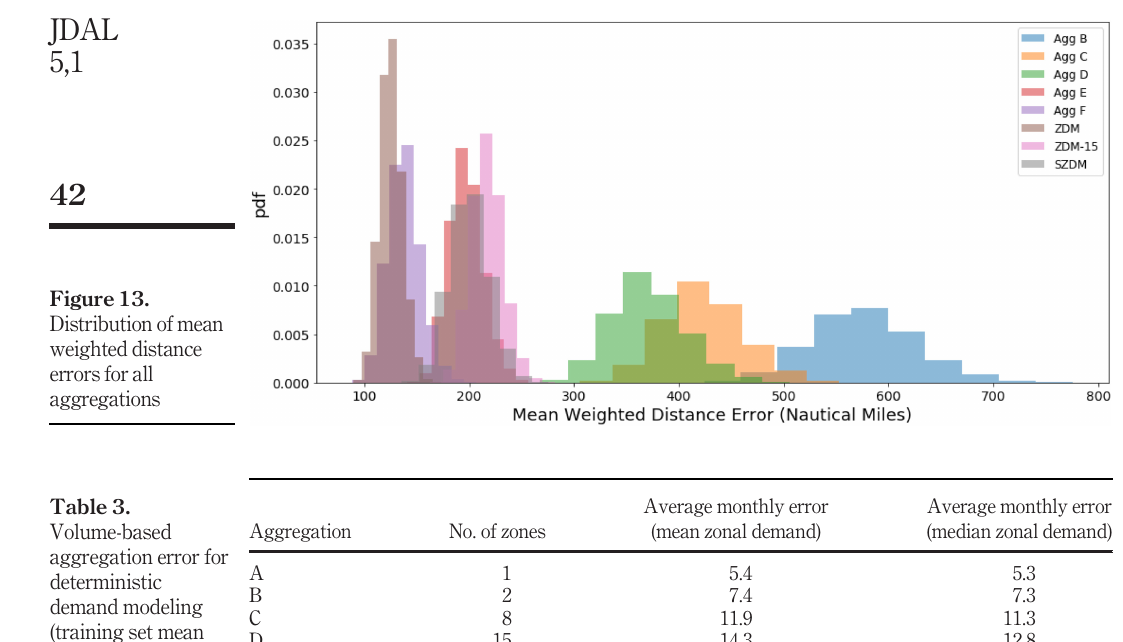
Aggregation No. of zones